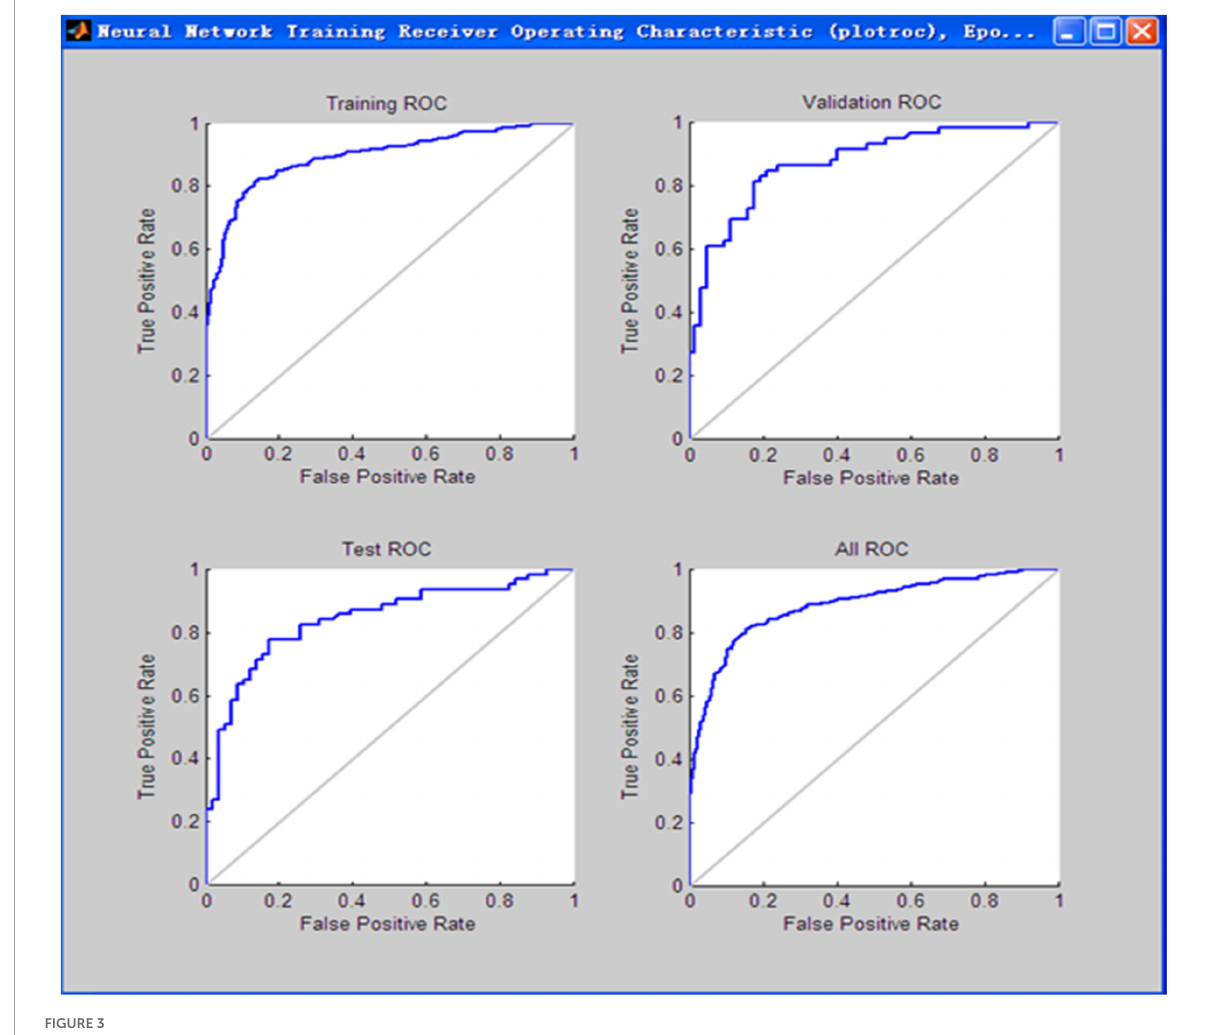
FIGURE3 The receiver operating characteristic (ROC) curve of Back Propagation Neural Network (BPNN) for each sample.